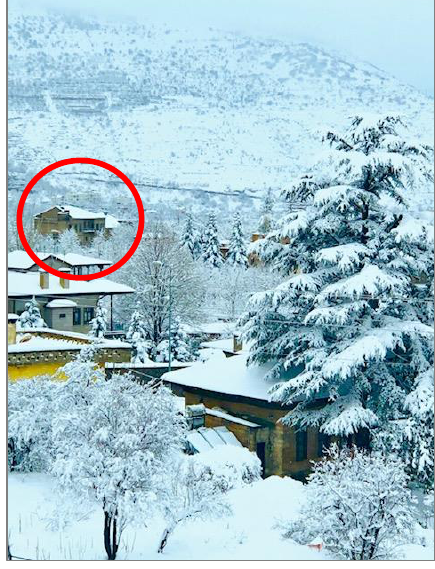
Figure 26 Karaman Mansion (Parlak Biçer,